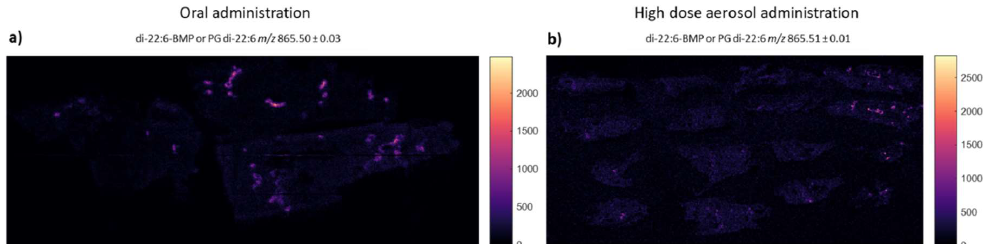
Figure 4. Selected ion images show the distribution of the major fragment ions of ( a , b ) amiodarone ( m / z 646.03), ( c , d ) n -desyl amiodarone ( m / z 618.00), and metabolites ( e , f ) M8 ( m / z 662.02) and ( g , h ) M11 (633.99). Images A, C, E and G each represent 27.2 mm by 20.3 mm in the x and y dimension respectively. Images B, D, F and H each represent 46.5 mm by 23.3 mm in the x and y dimension respectively.